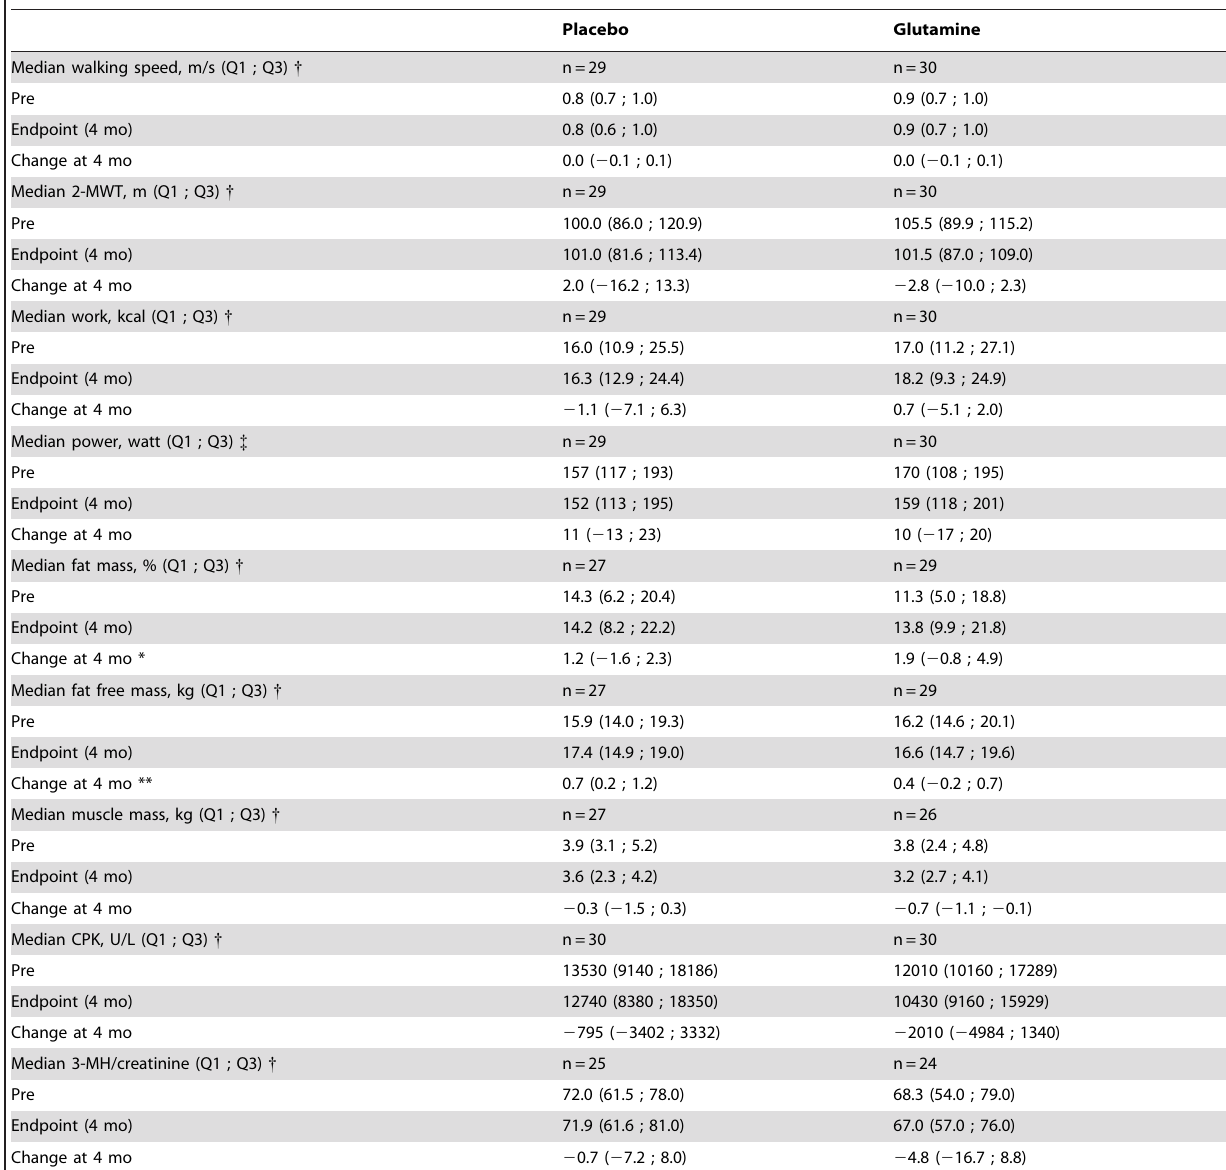
* p , 0.05 (glutamine vs placebo, repeated-measures analysis of variance without order effect or interaction). ** p , 0.05 (glutamine vs placebo, repeated-measures analysis of variance with order effect). { Logarithmic transformation. { Square root